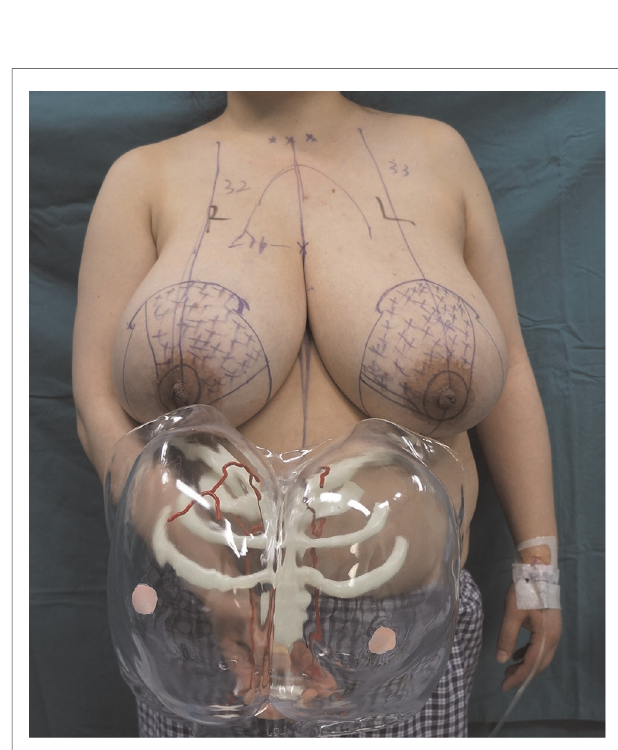
FIGURE 2 | Personalized preoperative 3D-printed breast vascular model